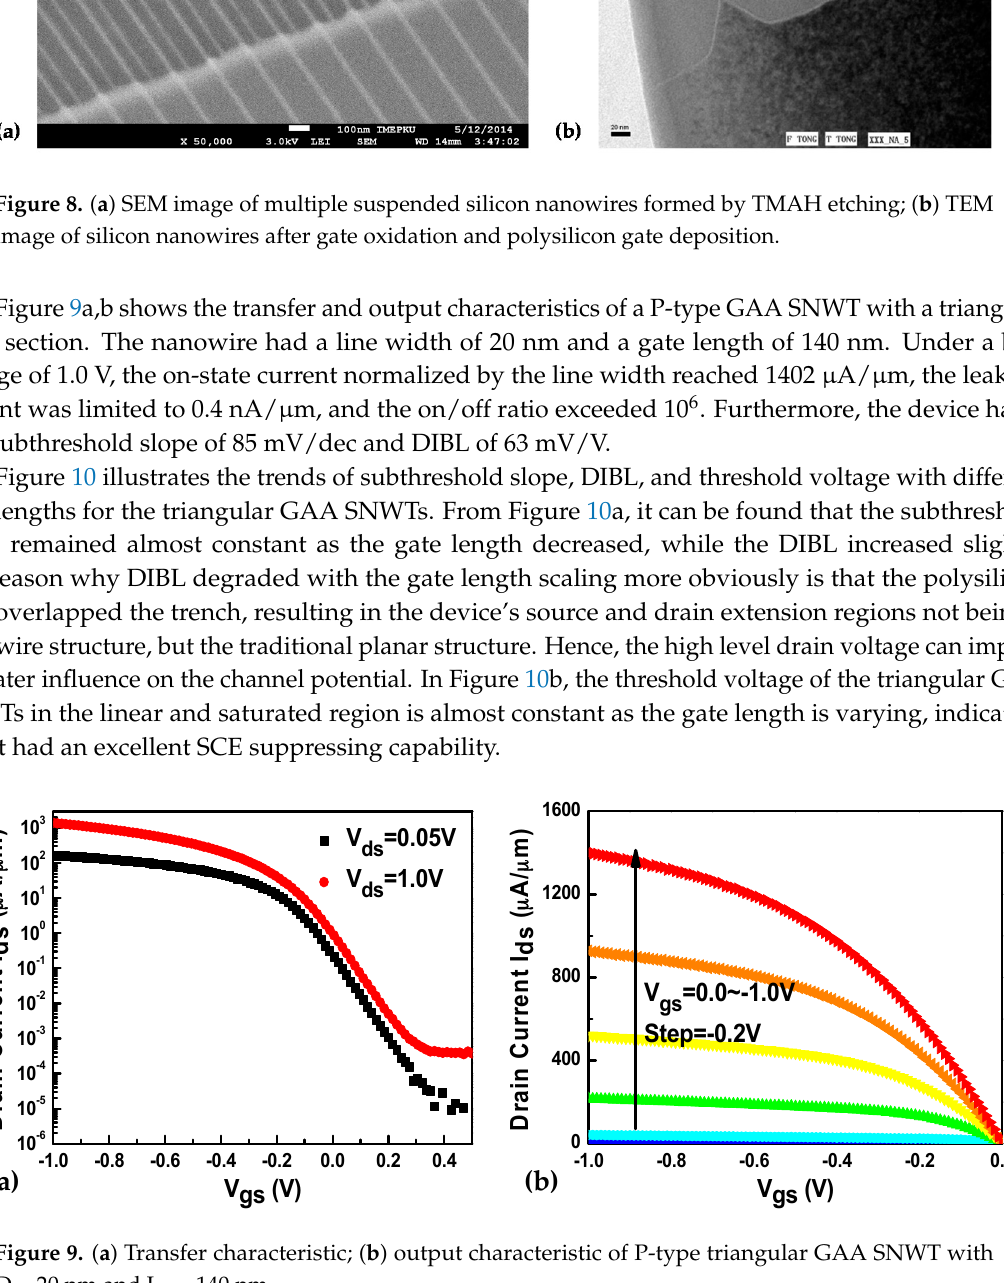
Figure 10. The trends of SS, DIBL, and V th with L g for triangular cross-sectional GAA SNWTs. 5. Mobility Model In this section, we plan to characterize the carrier mobility in the fabricated GAA SNWTs by Bias-Temperature experiments so that surface roughness mobility can be obtained at a low temperature, which can verify the benefit to mobility resulting from the stable and smooth triangular cross-sectional shape. The Y-function method can be used to extract the mobility of the fabricated triangular cross- sectional GAA SNWTs [16]. The Y function can be calculated as follows: